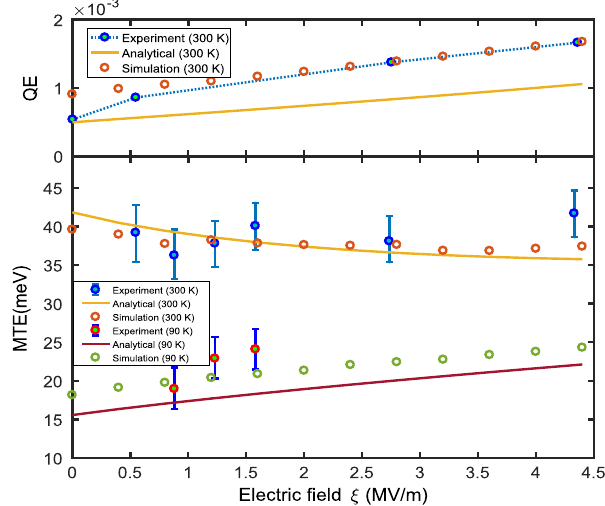
FIG. 2. Comparison between the analytical results, simulation results and the experiment data [12] in QE and MTE for Cs 3 Sb threshold photoemission with 690 nm laser. The MTE plots include data points at two temperatures, 300 K and 90 K. The thickness of the photocathode is assumed to be 30 nm.